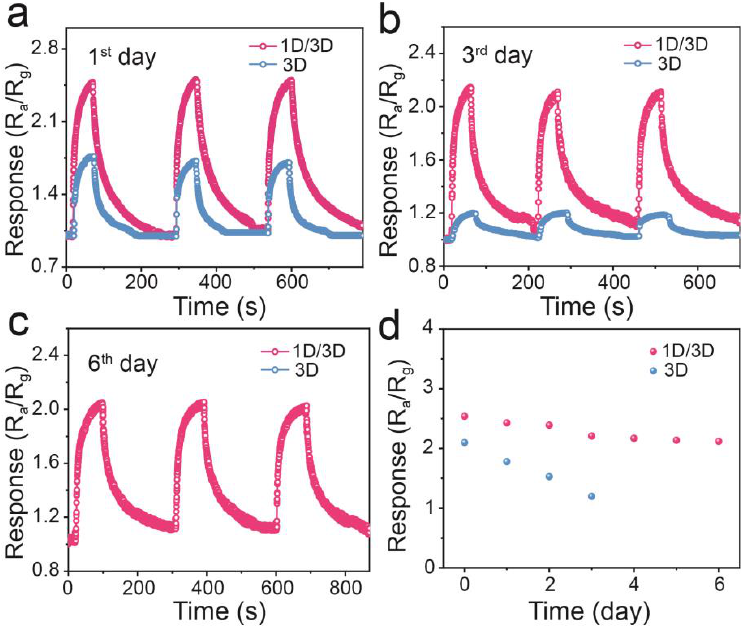
Figure 6. Long-term stability of 1D/3D hybrid-structured PyPbI 3 /FACs and 3D FACs perovskite- based sensor toward 10 ppm NO 2 recorded at the 1st ( a ), 3rd ( b ) and 6th day ( c ). ( d ) Time-dependent response value.